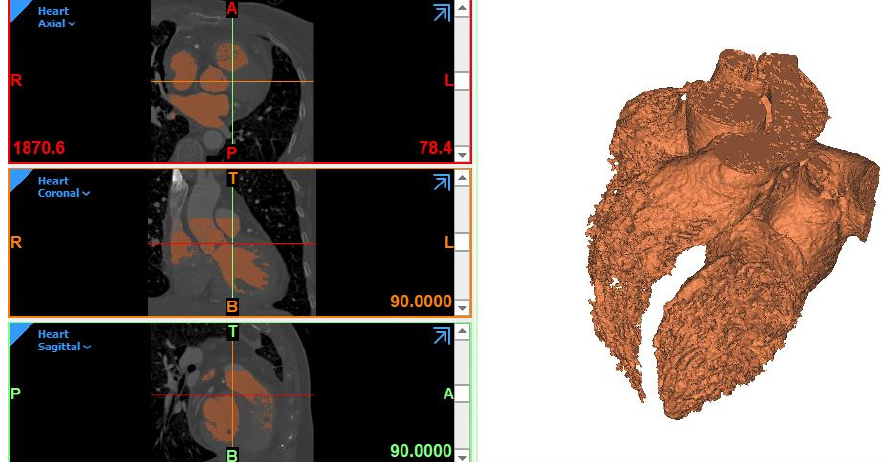
Figure 2. On the left, the segmented region seen according to three different planes from a Mimics screenshot. On the right, the correspondent preliminary, rough model of the blood pool. We can appreciate that the right ventricle is not well defined here.